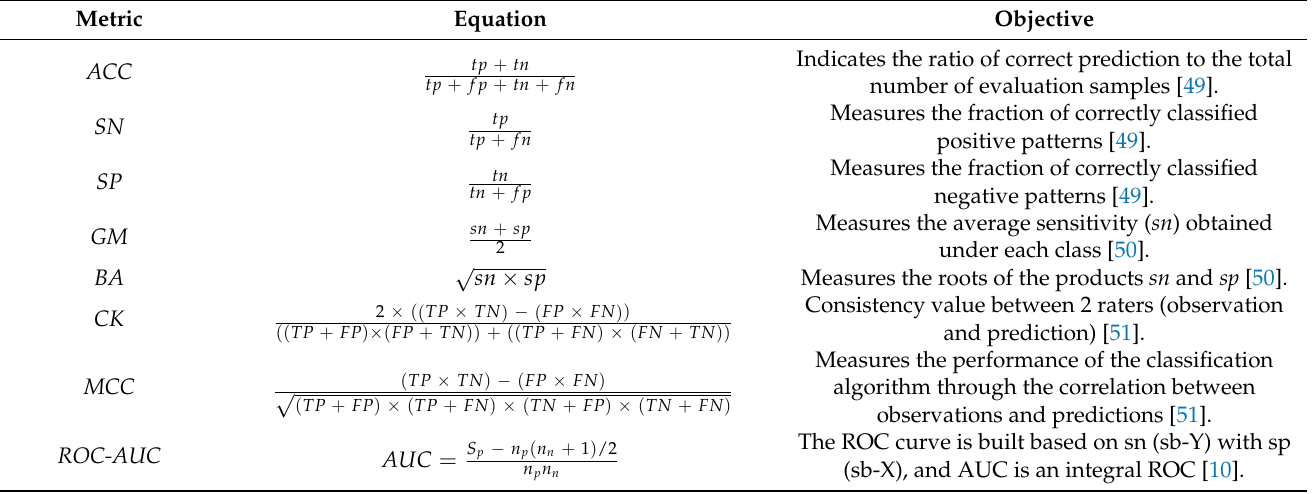
Table 2. Metric evaluator equation and each objective.